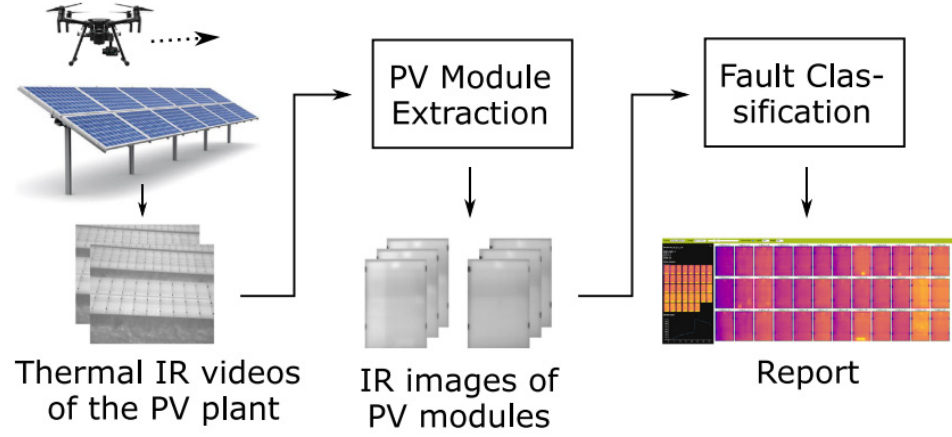
Figure 4. Overview of a tool for semi-automatic inspection of large-scale PV plants using IRT videos acquired by a UAV [88].